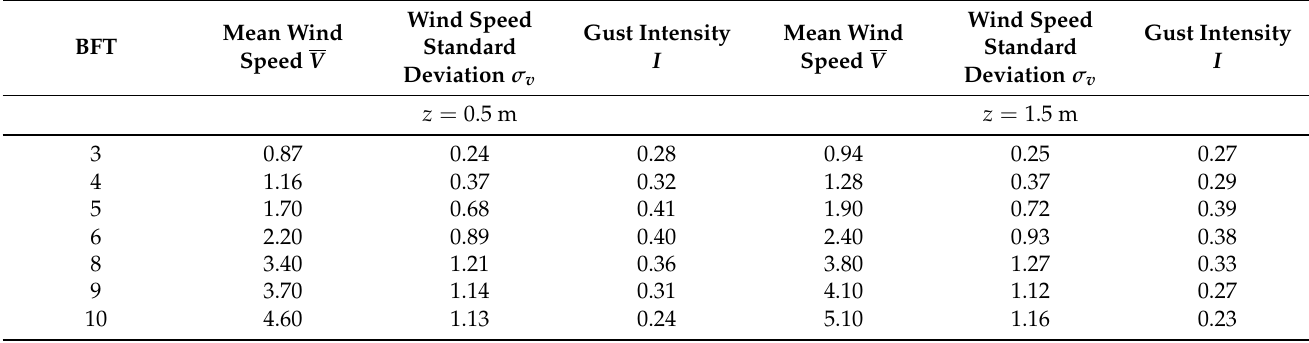
Table 3. Statistical parameters of wind sped measurements.